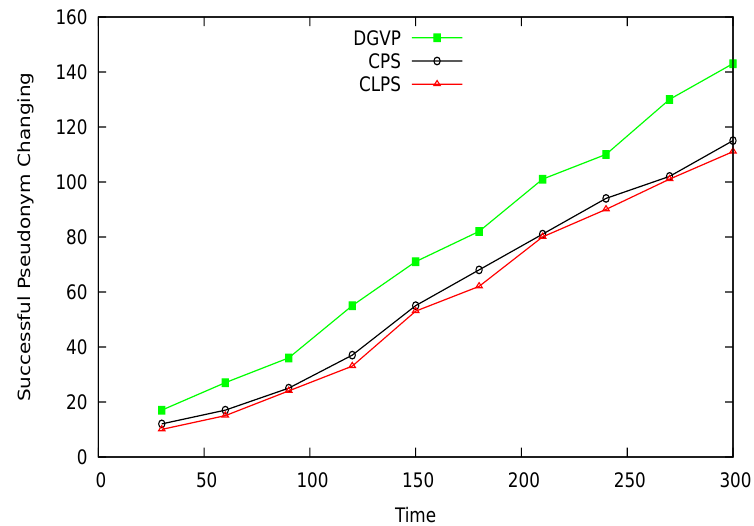
Figure 21. Vehicles successful pseudonym-changing at different